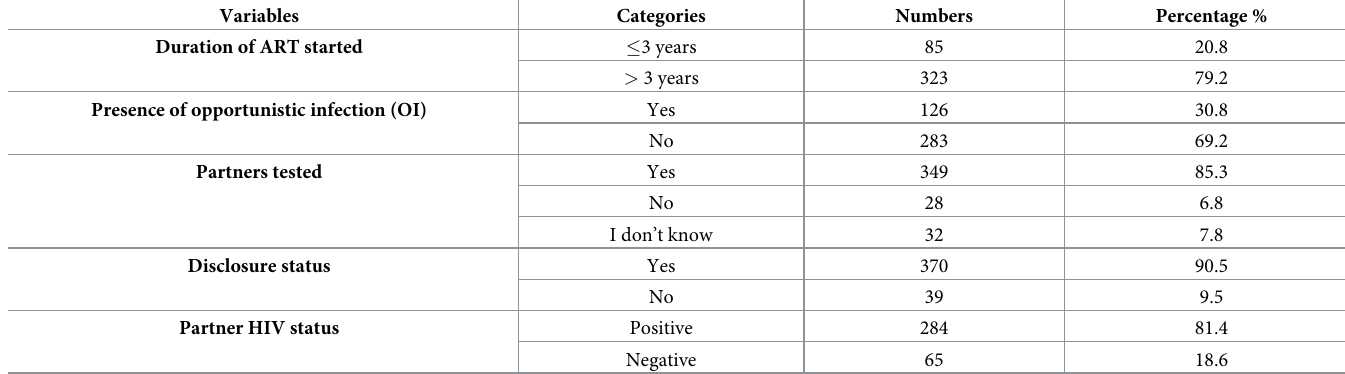
Table 3. HIV related factors of married reproductive age women attending ART clinics in Dire Dawa administrative city Eastern Ethiopia, March-June 2020.